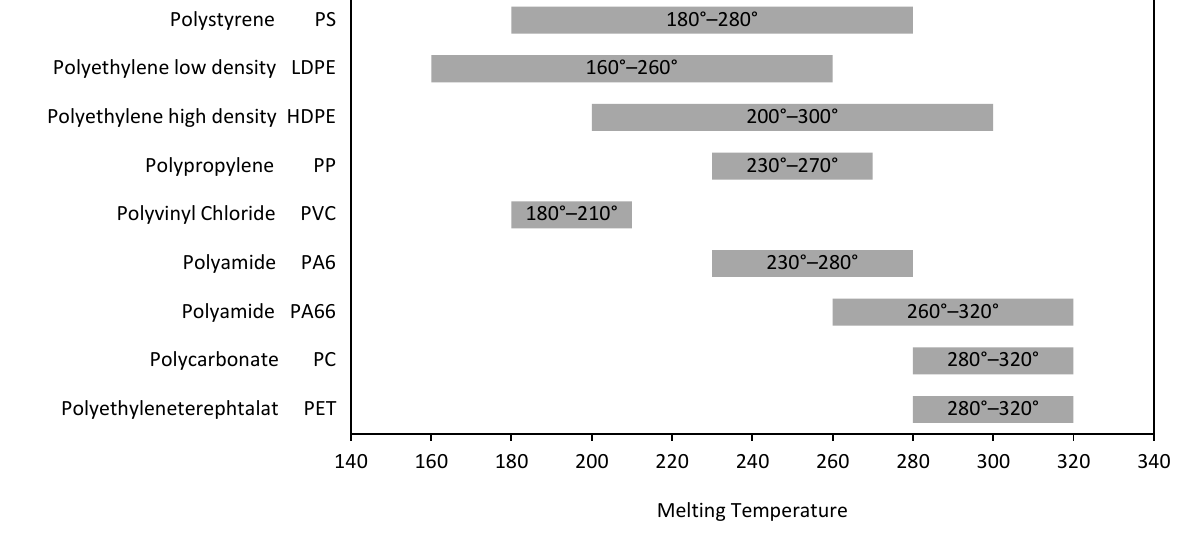
Figure 1. Processing temperatures of common thermoplastics [40].